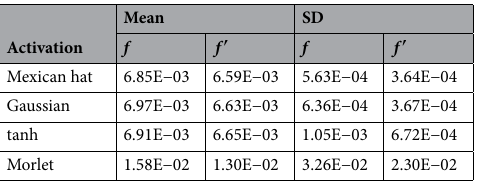
Table 1. Average and SD of relative L 2 error of the proposed method in solving Blasius equation using different activation function compared against WGM over 10 instances.